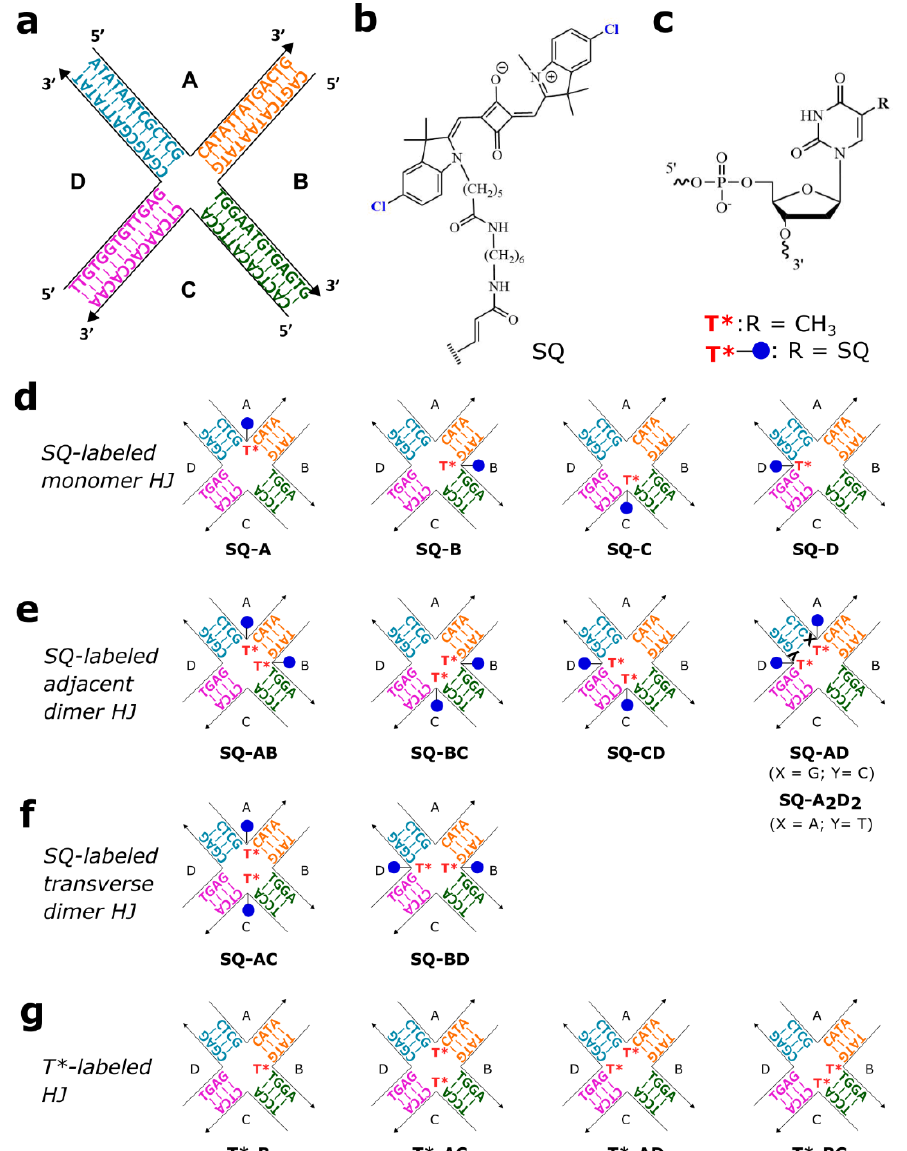
Figure 2. Structures of dye-DNA constructs. ( a ) Base sequence of the unmodified four-arm immobile DNA Holliday junction. The constituent single strands of DNA HJ are labeled A, B, C, and D; the complementary regions are color-coded. ( b ) Chemical structure of dichloroindolenine squaraine and tether. ( c ) Chemical structure of the unlabeled thymine modifier (T*) and thymine-modifier tethered to the squaraine (T*-blue circle). ( d – g ) The central sequences of the modified HJs depicting the positions of squaraine-labeled and unlabeled thymine modifiers T*. Blue circles depict thymine modifiers tethering a squaraine dye. The base sequences beyond the central four base pairs of each arm are identical to those in the unmodified HJ.